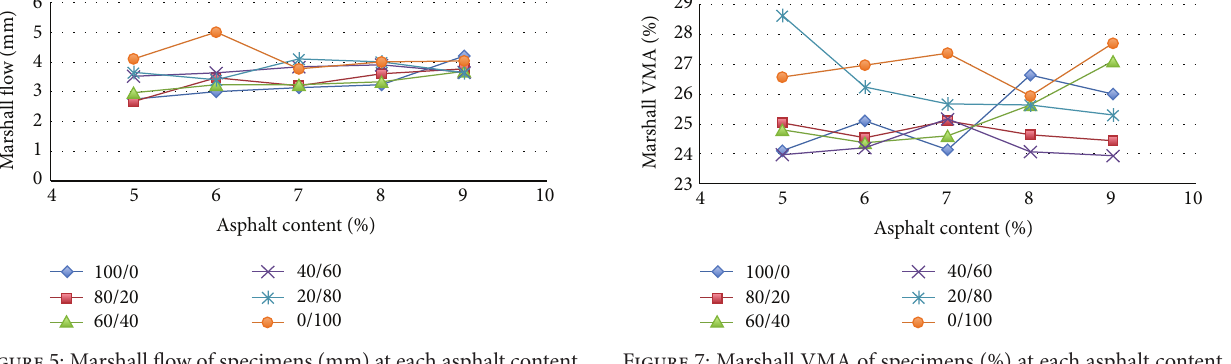
Figure 5: Marshall flow of specimens (mm) at each asphalt content and coarse aggregate proportion.